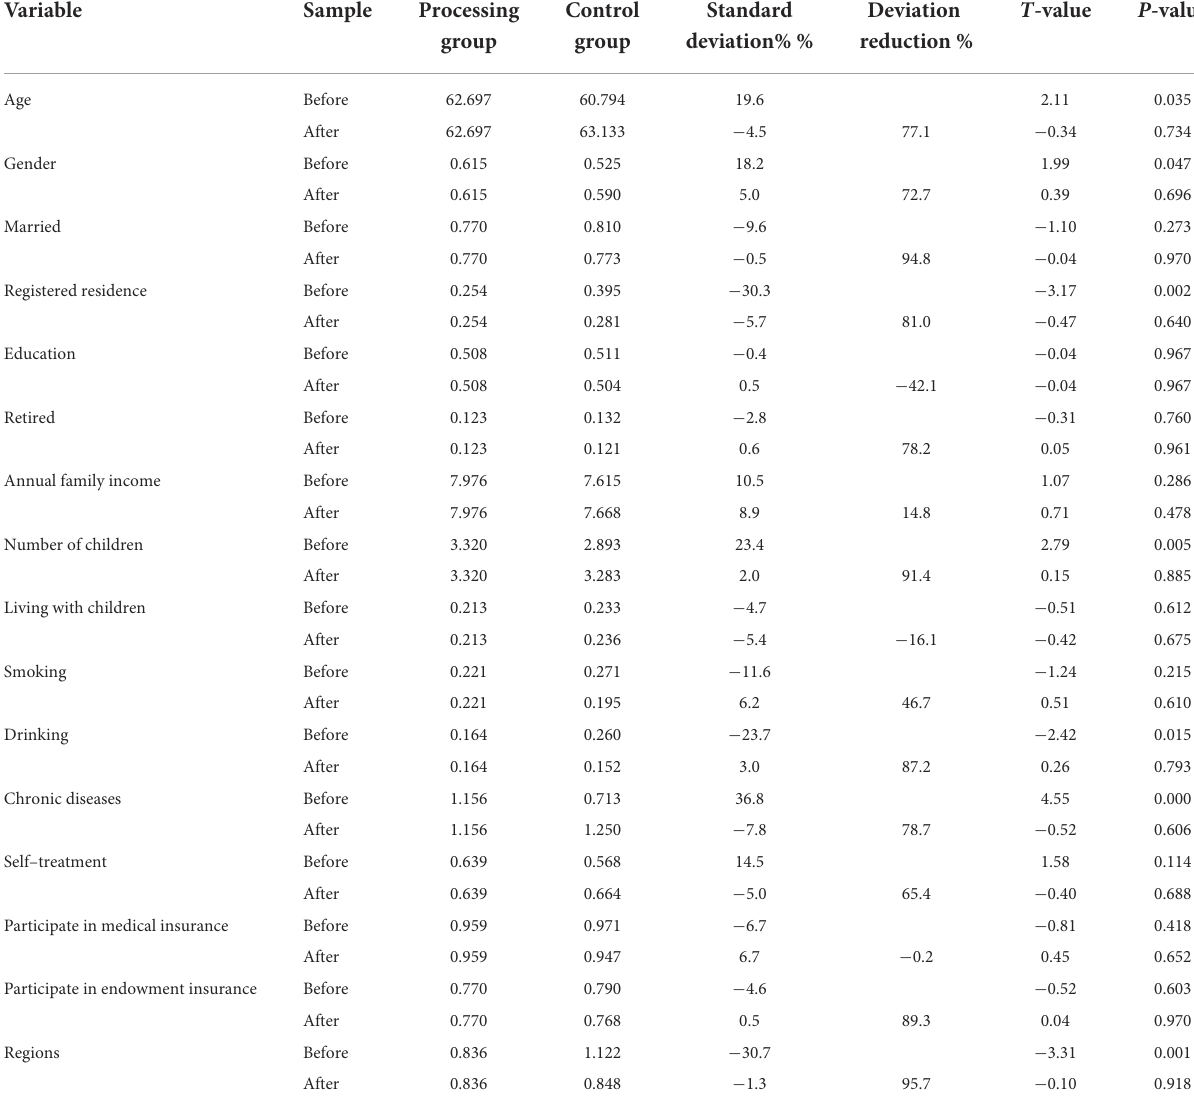
TABLE 4 Sample balance test of propensity score